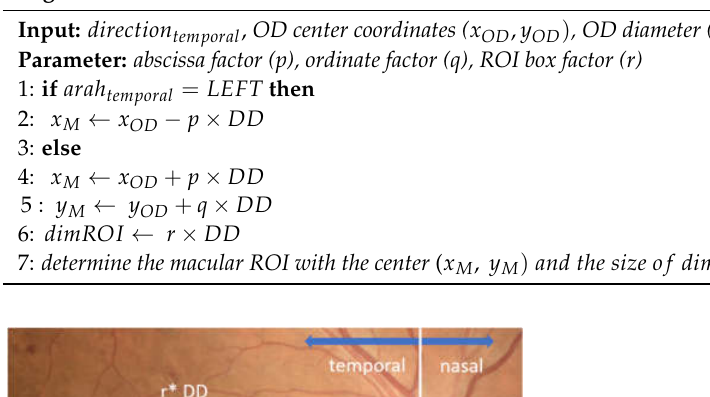
Algorithm 1: Macular ROI determination